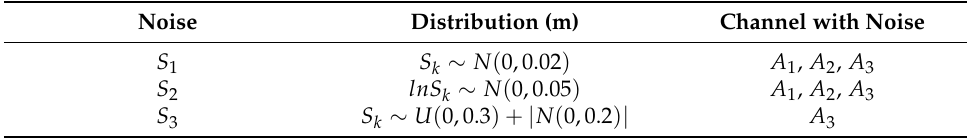
Figure 5. Simulated environment. Table 1. Three kinds of noise between the tag and the